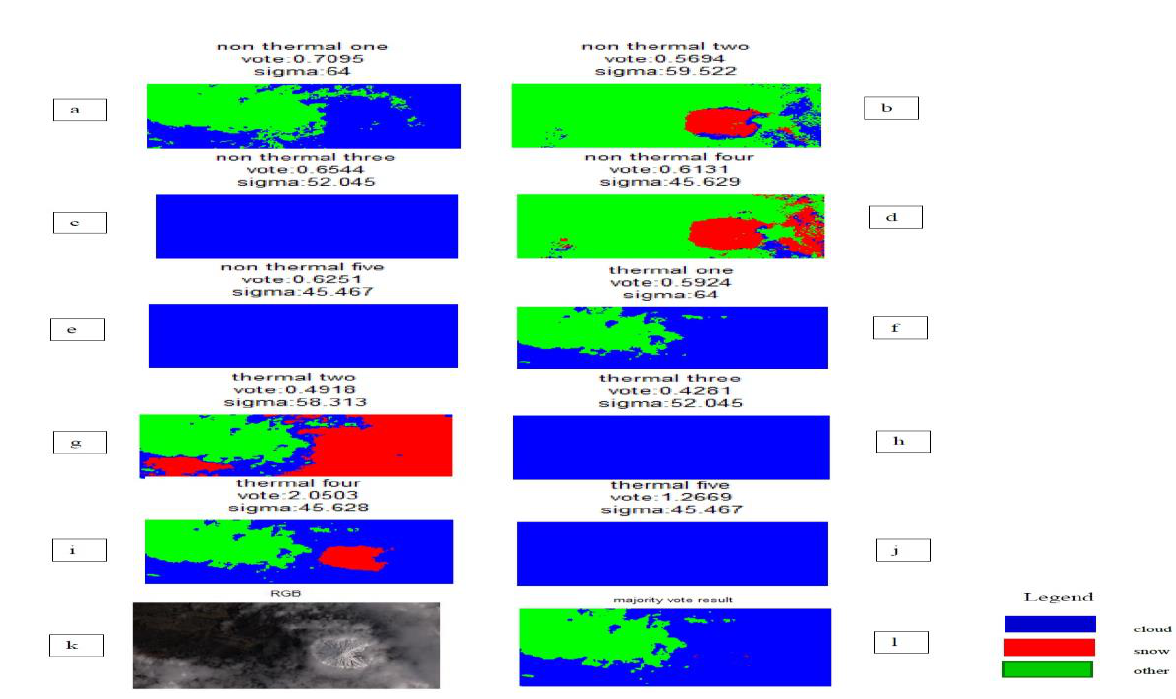
Fig. 6: a-e: classification results of σ Boost on non-thermal bands; f-j: classification results of σ Boost on thermal bands; k:RGB image; l: fusion result